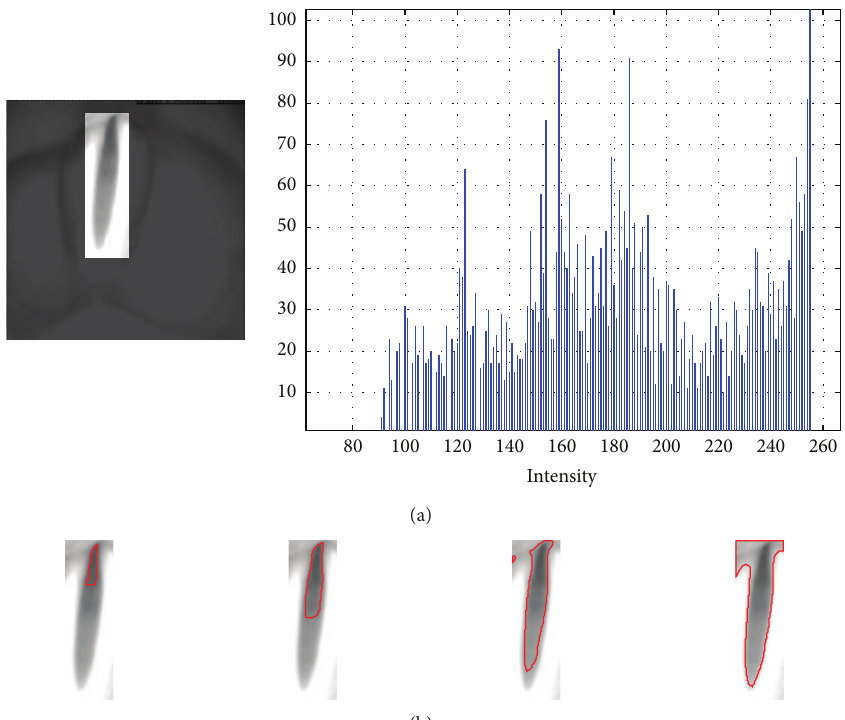
Figure 11: (a) Masked HSV image and its histogram. (b) Boundary of the vocal folds in the masked image obtained by thresholding with 110, 140, 170, and 210,